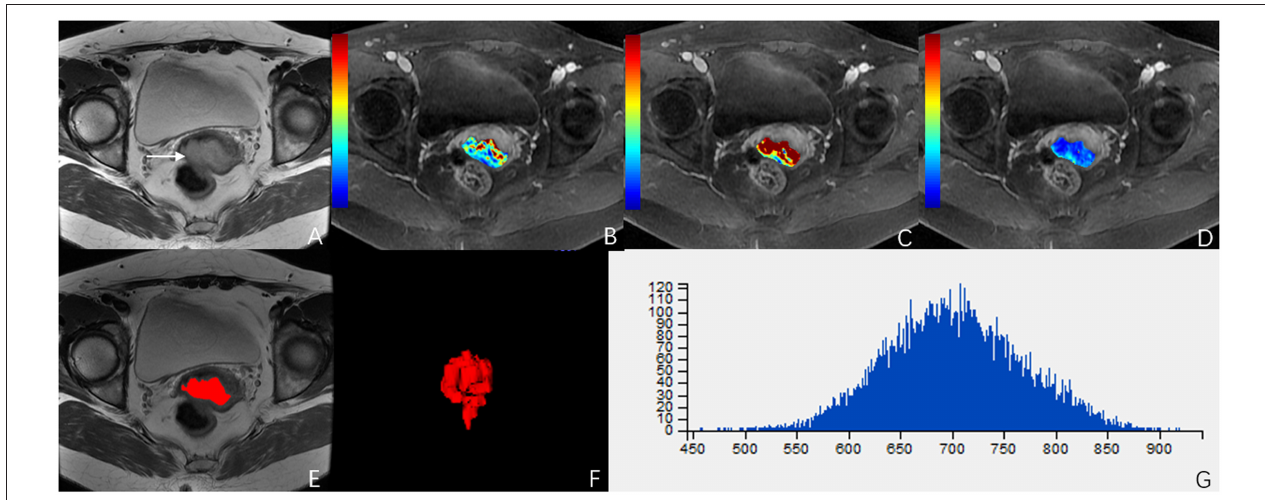
FIGURE 5 | A 49-year-old woman with stage IIA cervical cancer. (A) T2-weighted image (T2WI) shows a slightly hyperintense cervical mass. (B–D) K trans , K ep , and V e parametric maps are derived from DCE-MRI. The corresponding values are 0.196/min, 0.430/min, 0.396. (E,F) The volume of the tumor is drawn from T2WI. (G) Histogram map of the entire